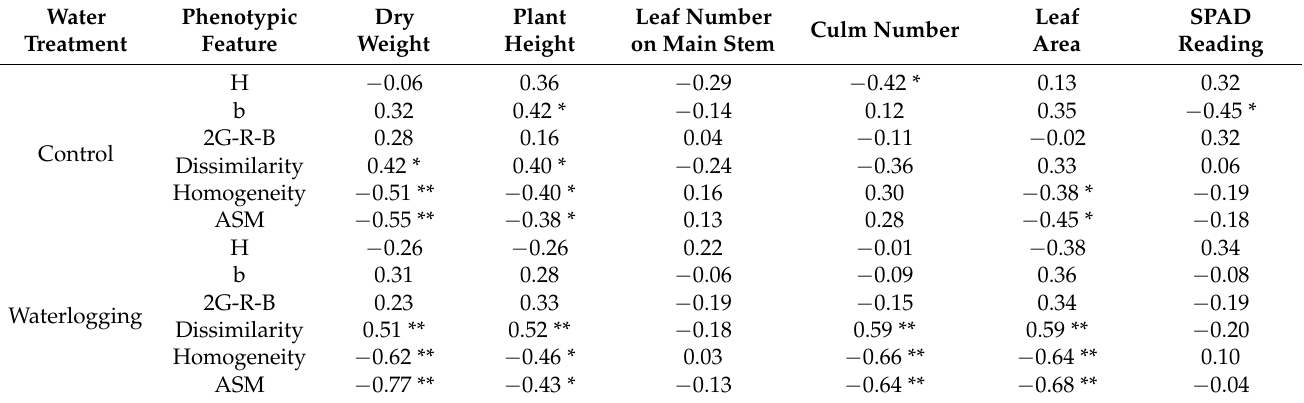
Table 8. Correlation coefficients of selected phenotypic features extracted from images of the side view with agronomic traits under control and waterlogging